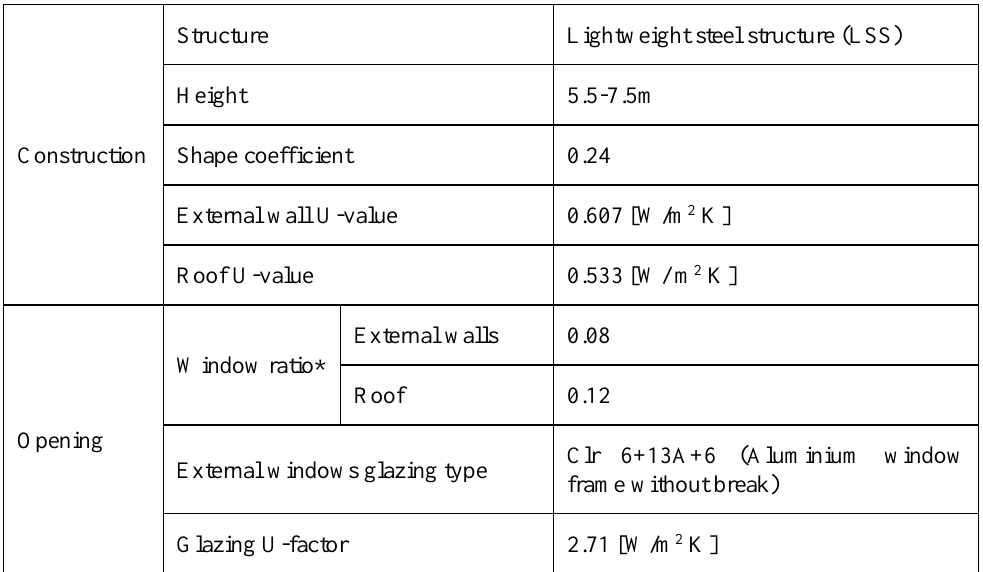
Figure 2 The envelope, structure, and simulation model of the reference building. Table 1. Basic properties of the reference